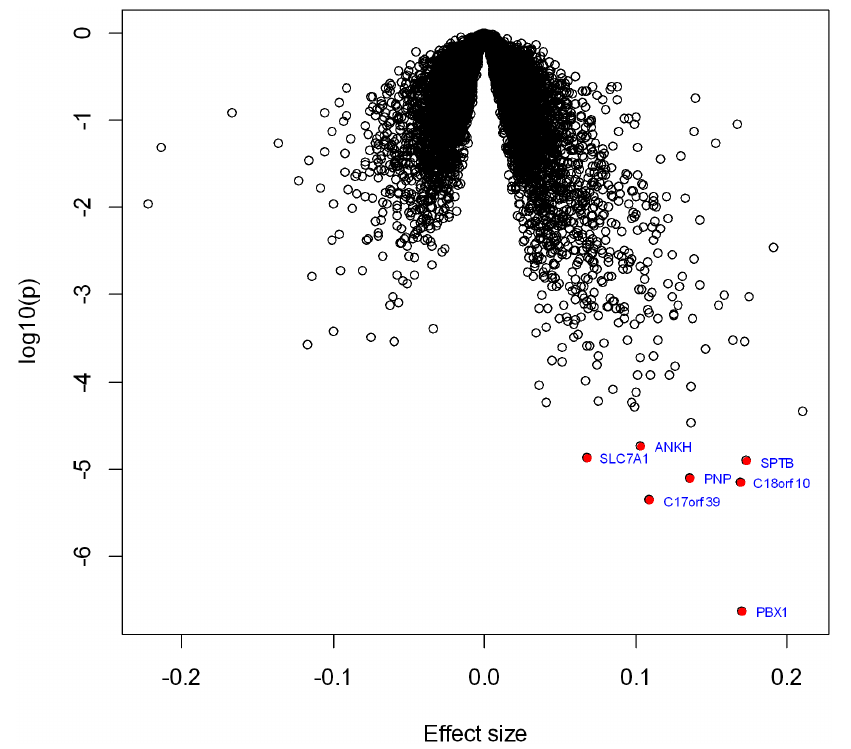
Figure 1. Volcano plot of expression association with prevalent AF. Each dot represents one gene. The x-axis represents the effect of each gene, whereas the y-axis represents the log 10 ( P value). Positive effects represent that the genes were over-expressed in prevalent AF, while negative effects represent that the genes had decreased expression with prevalent AF. Seven genes that reached the significant cutoff (FDR , 0.05) were marked.